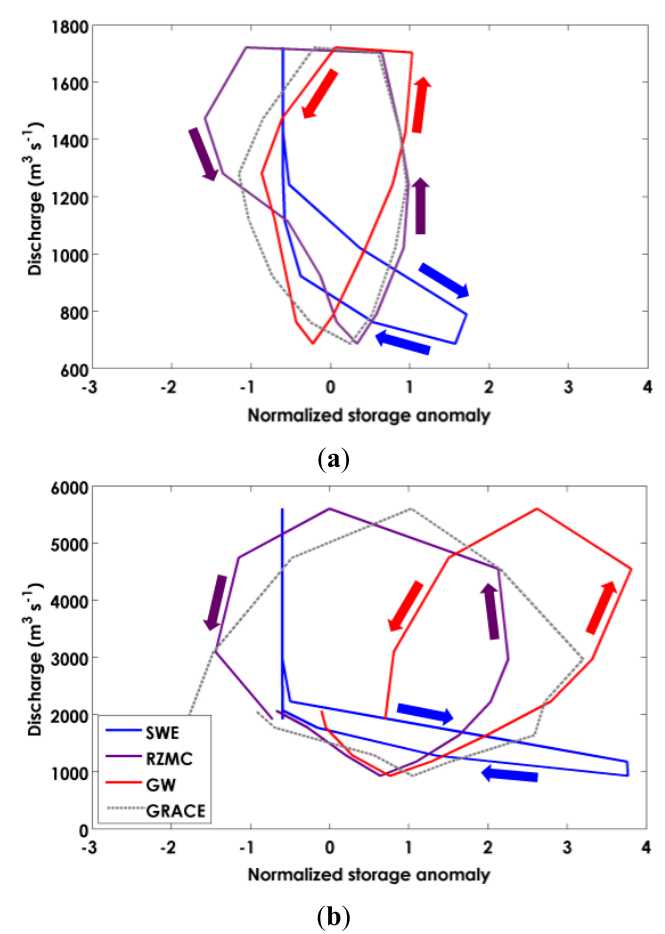
Figure 7. Hystereses between stream flow at the mouth and snow water equivalent (SWE), root-zone soil moisture (RZMC), or groundwater (GW) in the CLSMDA during ( a ) the climatological average of all years; and ( b ) the 2011 flood year. Raw GRACE data are shown for comparison. Hystereses run from October to